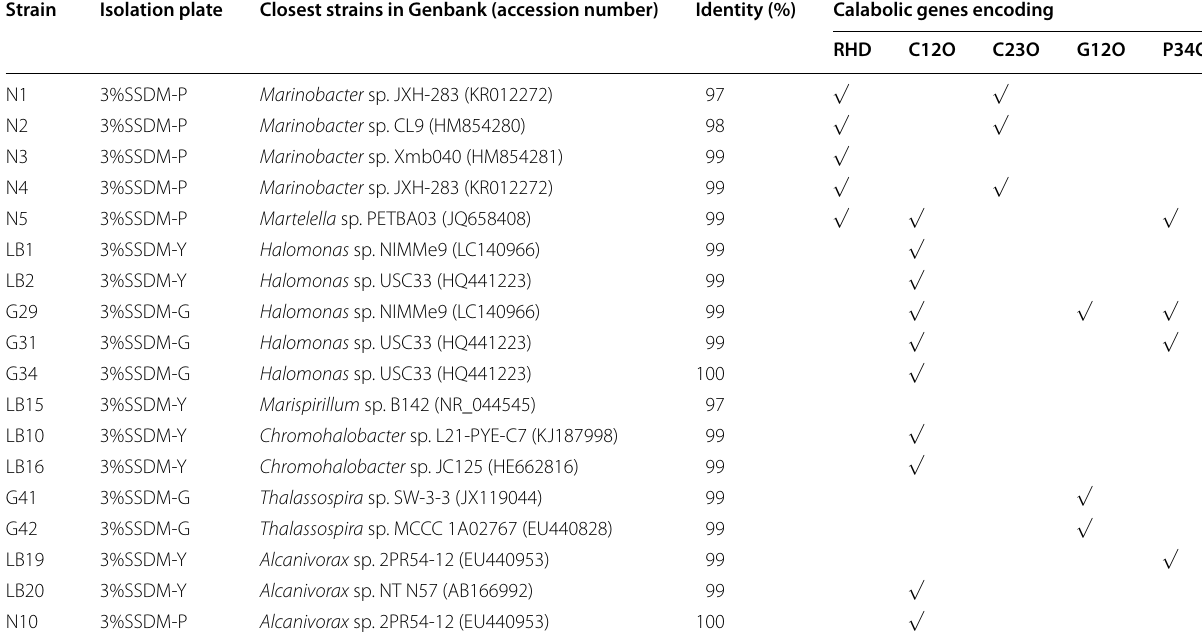
Table 3 Identification of catebolic genes contained in species isolated form consortium CY-1 Strain Isolation plate Closest strains in Genbank (accession number) Identity